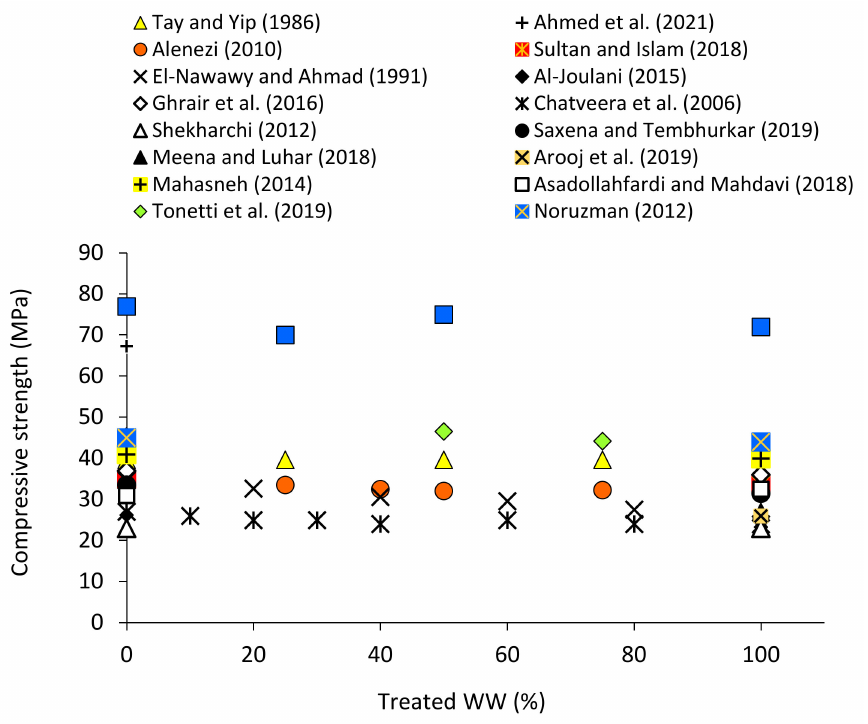
Figure 7. The effect of treated WW on the compressive strength of concrete reported in different studies.